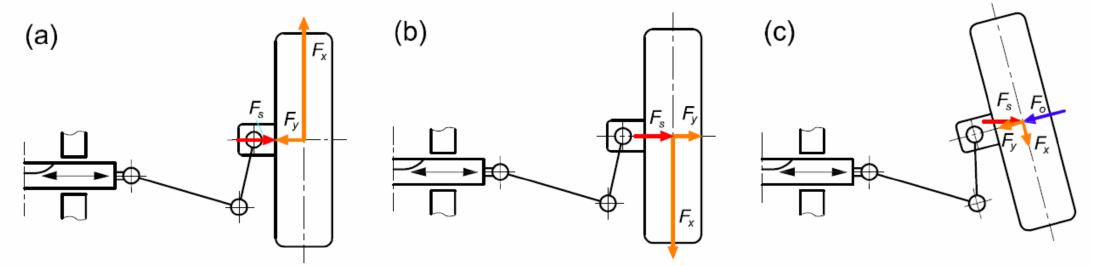
Figure 5. Forces acting on the rocker arm pin during various cases of vehicle motion (for a positive swing radius): ( a ) acceleration, ( b ) braking, ( c ) driving along a road curve: F s —side force, F y —lateral force, F y —longitudinal force, F s —centrifugal